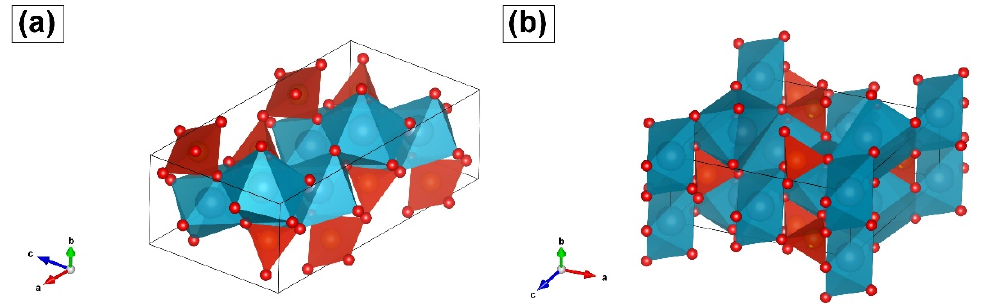
Figure 2. Molecular structure model diagrams of the calcium vanadates: ( a ) Ca 2 V 2 O 7 ; ( b ) Ca 3 (VO 4 ) 2 . The following color designation was used: calcium–blue; oxygen–red; vanadium–orange.